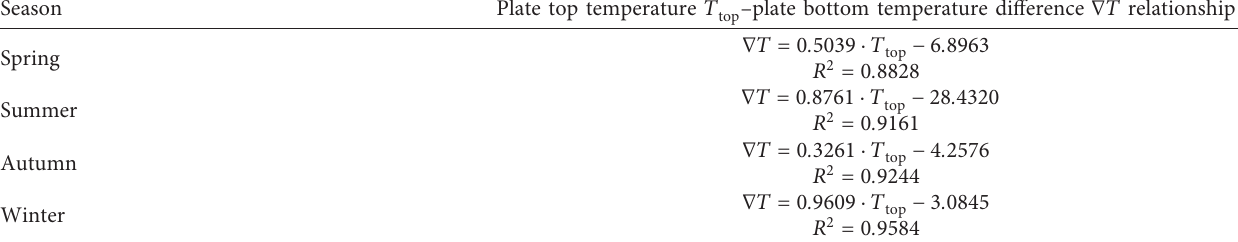
Table 4: Correlation equations expressing the relationship between the top temperature of cement concrete pavement plate and bottom temperature difference of plate.